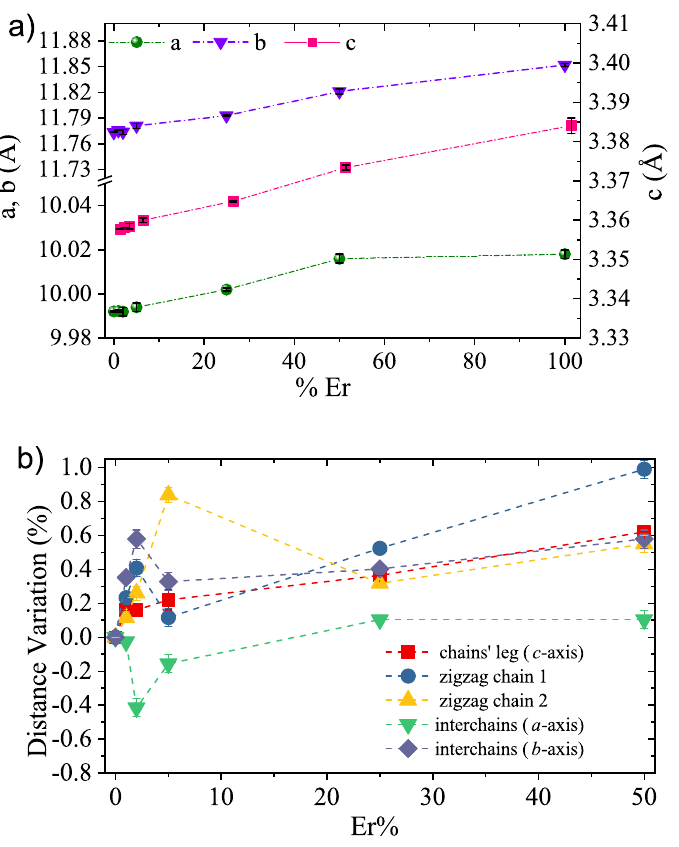
Figure 3. ( a ) Lattice parameters as a function of Er content extracted from the refinement of FIREPOD data (for Er1%, Er2%, Er5%, and Er50%) at room temperature and DMC data (for Er25%) at 10K. Lattice parameters for Er0% and Er100% were from [7]. ( b ) Percentage of variation of interatomic distances as a function of Er content, extracted from the refinement of neutron powder diffraction patterns collected on FIREPOD data at room